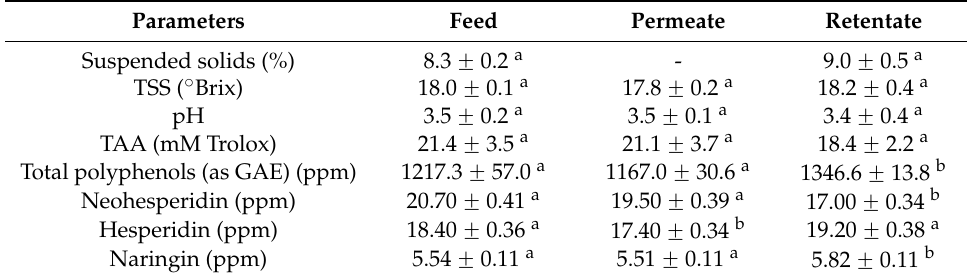
Table 3. Physico-chemical properties of orange press liquor treated by PVDF hollow fibers.